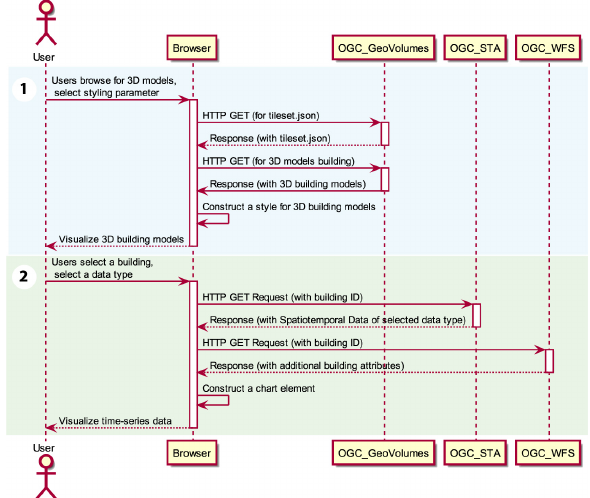
Figure 7. A sequence diagram of example user interactions in the EnSysLE UDT application.